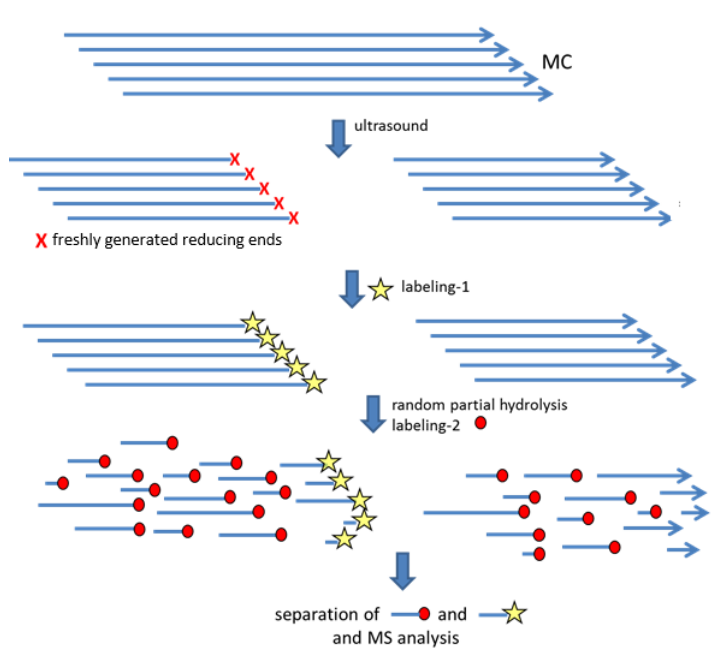
Figure 3. Concept of the analysis of the substituent distribution among the chains. Approximately one labeled COS/cellulose molecule shall be generated and separated from all COS of the same cellulose chain. The MC has been permethylated with MeI- d 3 prior to ultrasonic degradation. For details see text.